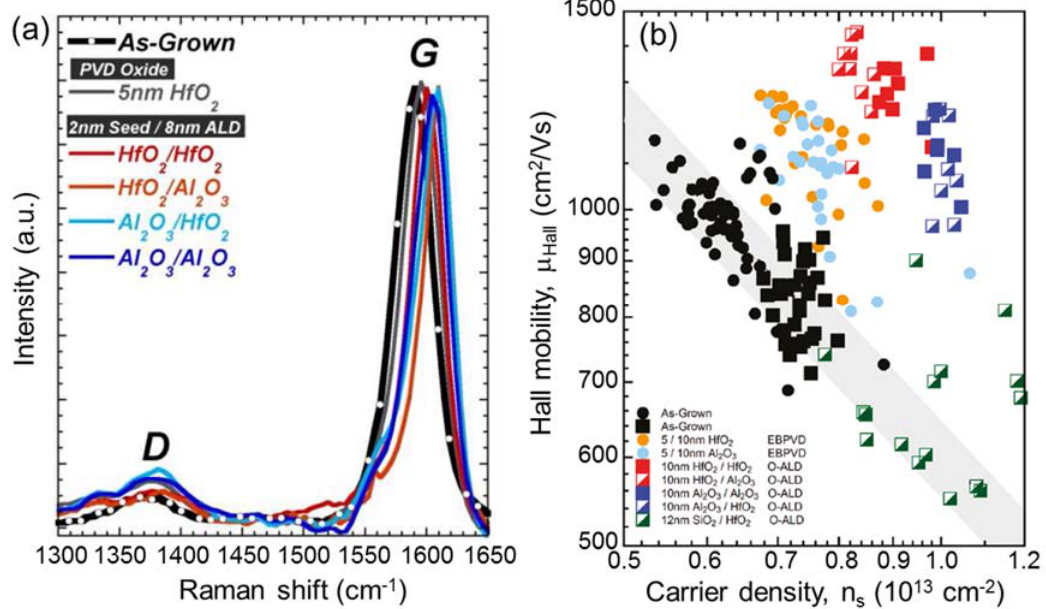
Figure 8. ( a ) Raman spectra of as-grown EG, after physical vapor deposition (PVD) of 5 nm HfO 2 and after HfO 2 -seeded (or Al 2 O 3 -seeded) ALD of HfO 2 and Al 2 O 3 . ( b ) Hall mobility µ Hall vs. carrier density n s measured on as-grown EG, after electron beam physical vapor deposition (EBPVD) of oxide seed-layers and the complete oxide-seeded ALD (O-ALD) process. Images adapted with permission from Ref. [35], Copyright American Chemical Society